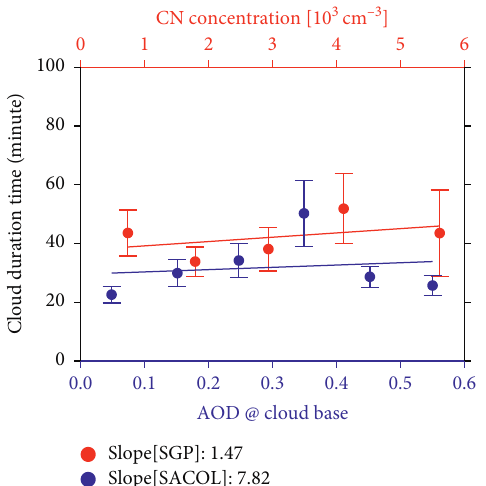
Figure 8: Cloud duration as a function of both aerosol CN con- centration at the SGP site (red x -axis) and aerosol optical depth below cloud base at the SACOL site (blue x -axis) for shallow warm clouds. Error bars show the standard deviations.